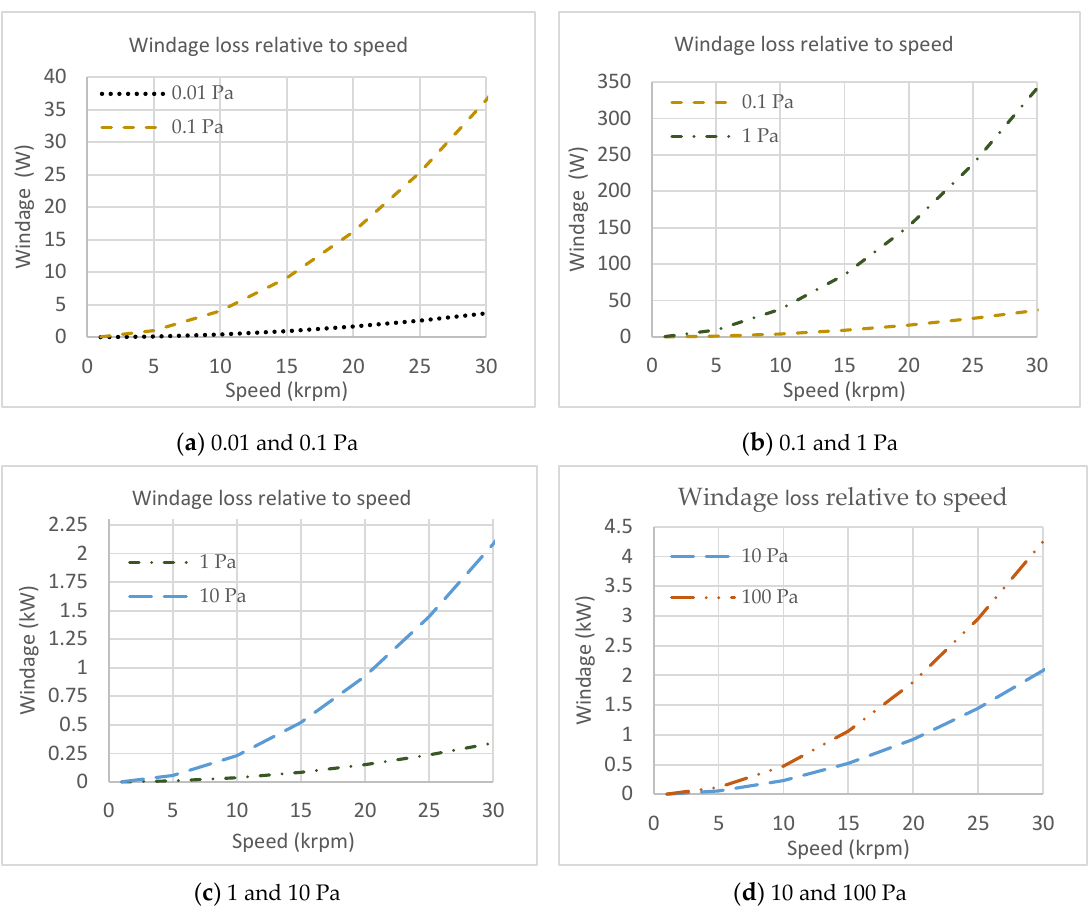
Figure 5. Aerodynamic drag loss relative to speed and pressure.